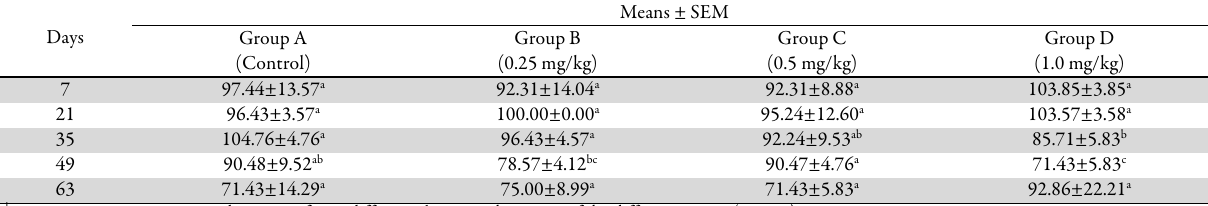
Table 1. Mean serum total cholesterol concentration (mg/dl) of albino rats given graded doses of whole quail egg per kilogram body weight (± SEM) Days